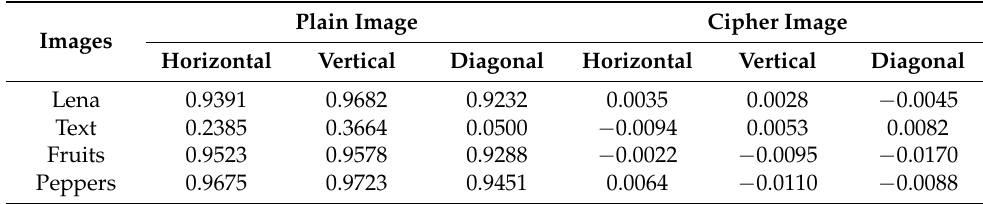
Table 5. Correlation coefficient test